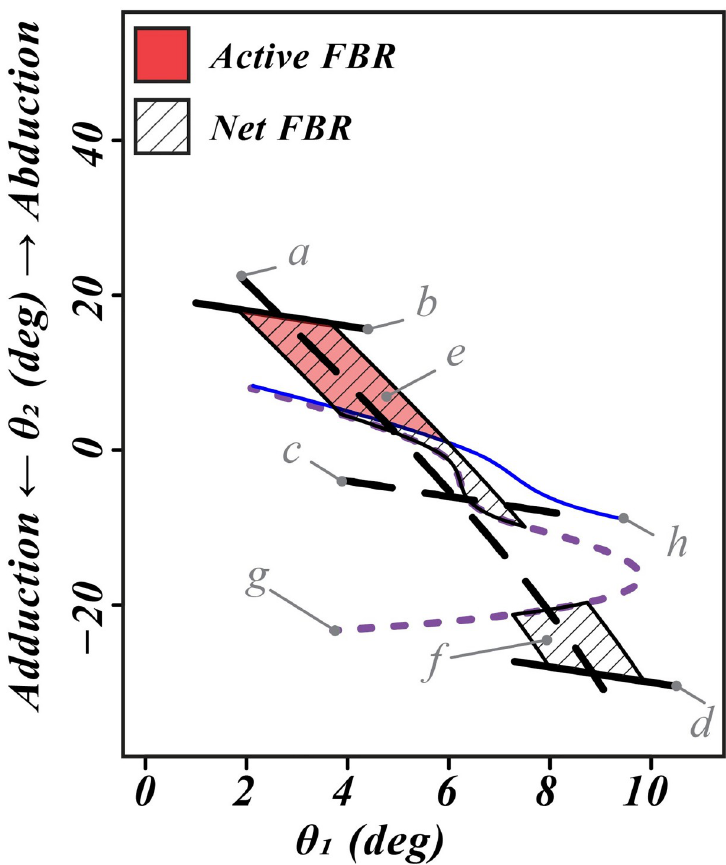
Fig 4. Example of passive tissue contribution to hip abduction moment during OLB in older men with PN. Calculated effect of significantly decreased active hip abduction strength on the FBR for older men with peripheral neuropathy. The locus of points tagged by grey letters a-g and the choice of colors are the same as described in Fig 3A.